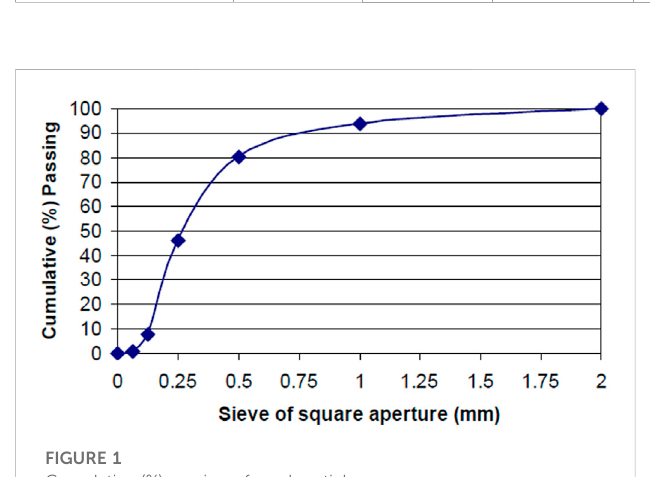
FIGURE 1 Cumulative (%) passing of sand particle.